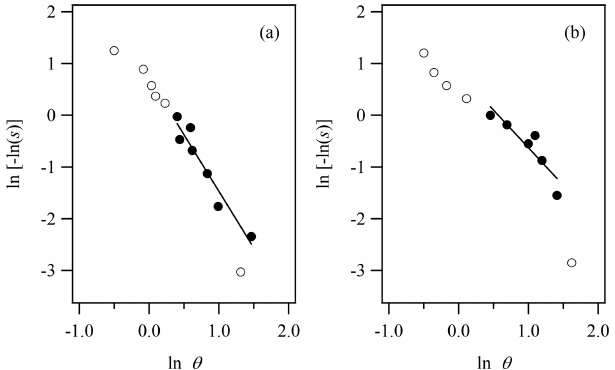
Figure 3. FHH analysis of experimental (a) illite and (b) montmo- rillonite water adsorption data in which θ was calculated as V/V m and V m was determined from BET analysis. All data (open circles) are shown and the region of the constrained FHH fit (line) is repre- sented by closed circles from 40% to 90%